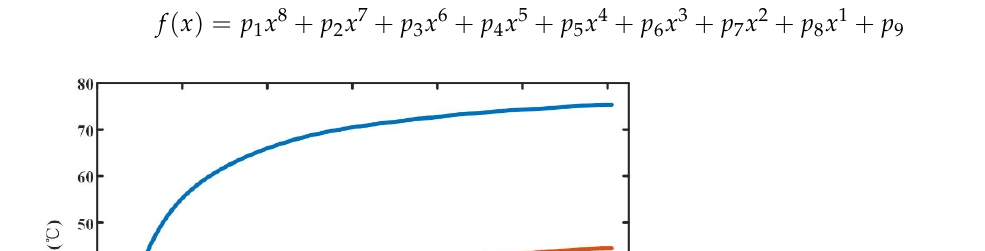
( b ) simulation with heating time of 60 min; ( c ) simulation with heating time of 120 min; ( d ) simula ‐